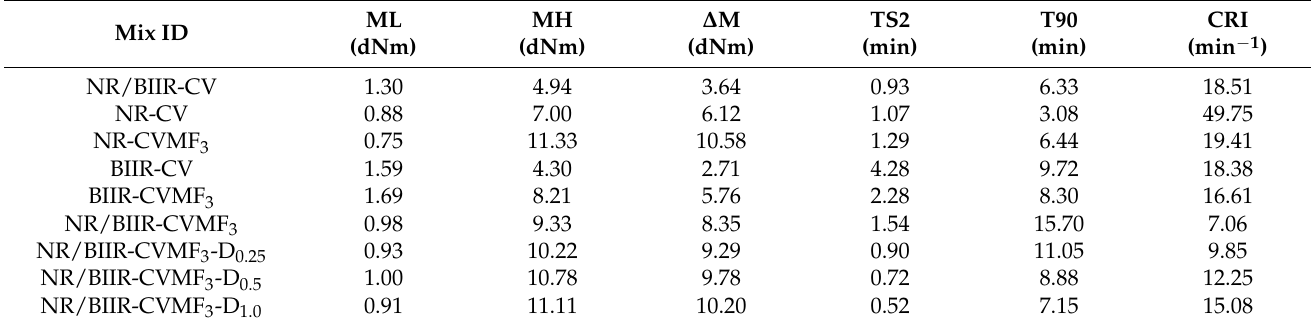
Table 2. Cure characteristics of the mixes at various temperatures.